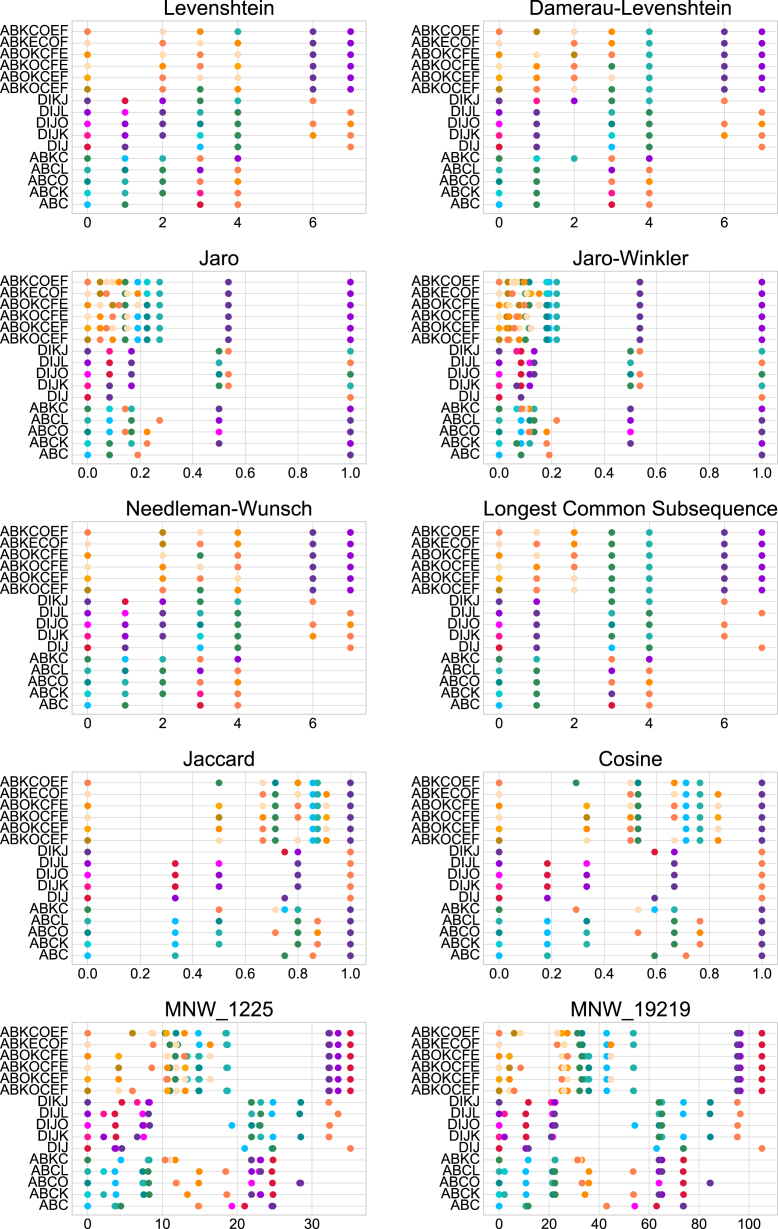
Comparison of the Ten Metrics Applied to Sample 2. (For interpretation of the references to colour in this figure legend, the reader is referred to the web version of this article.)